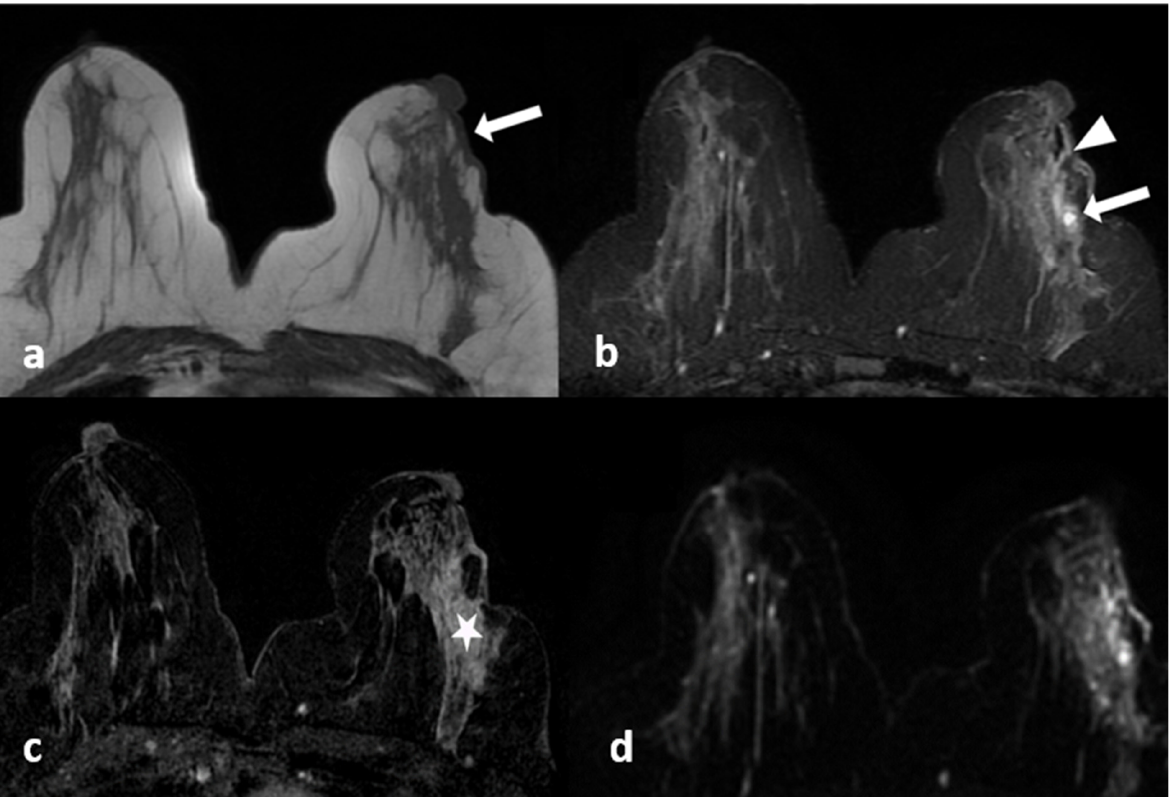
Figure 1. A 39-year-old woman with histopathologically proven idiopathic granulomatous mastitis involving the left breast. ( a ) T1-weighted fast spin echo axial MR image of the patient reveals a parenchymal asymmetry in the upper outer quadrant of the left breast and skin retraction with focal skin thickening (arrow); ( b ) axial fat-saturated T2-weighted fast spin echo MR image, corresponding to ( a ) a small cystic lesion (arrow) within an area of signal increase in parenchyma associated with edema; a fistulae formation is seen as hyperintense linear area extending to the skin (arrow- head). ( c ) Axial contrast-enhanced subtracted image visualizes a heterogeneous enhancement in the parenchyma (star), at the same level with ( a , b , d ): axial diffusion-weighted image shows hyperintense restricted area corresponding to ( a – c